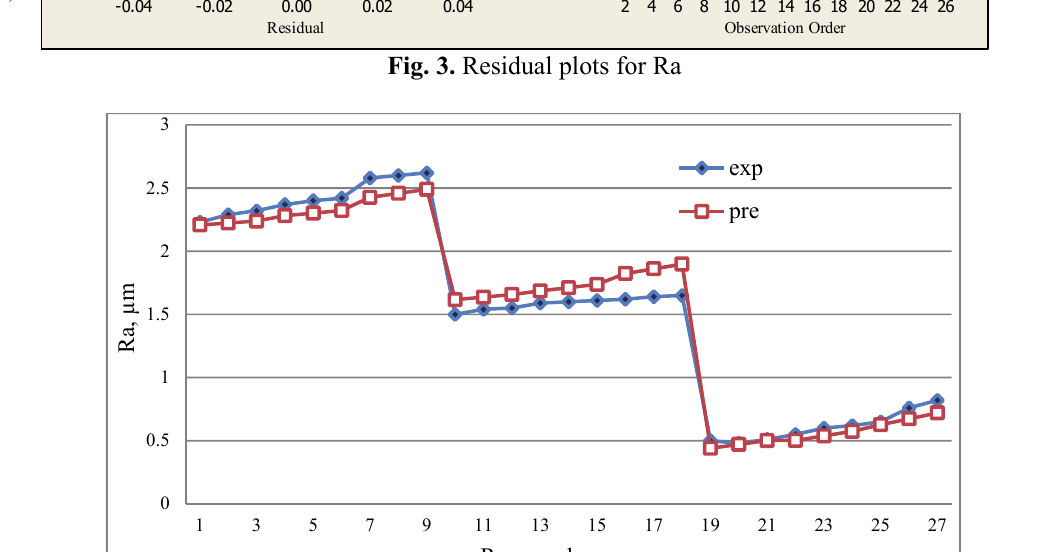
Fig. 3. Residual plots for Ra